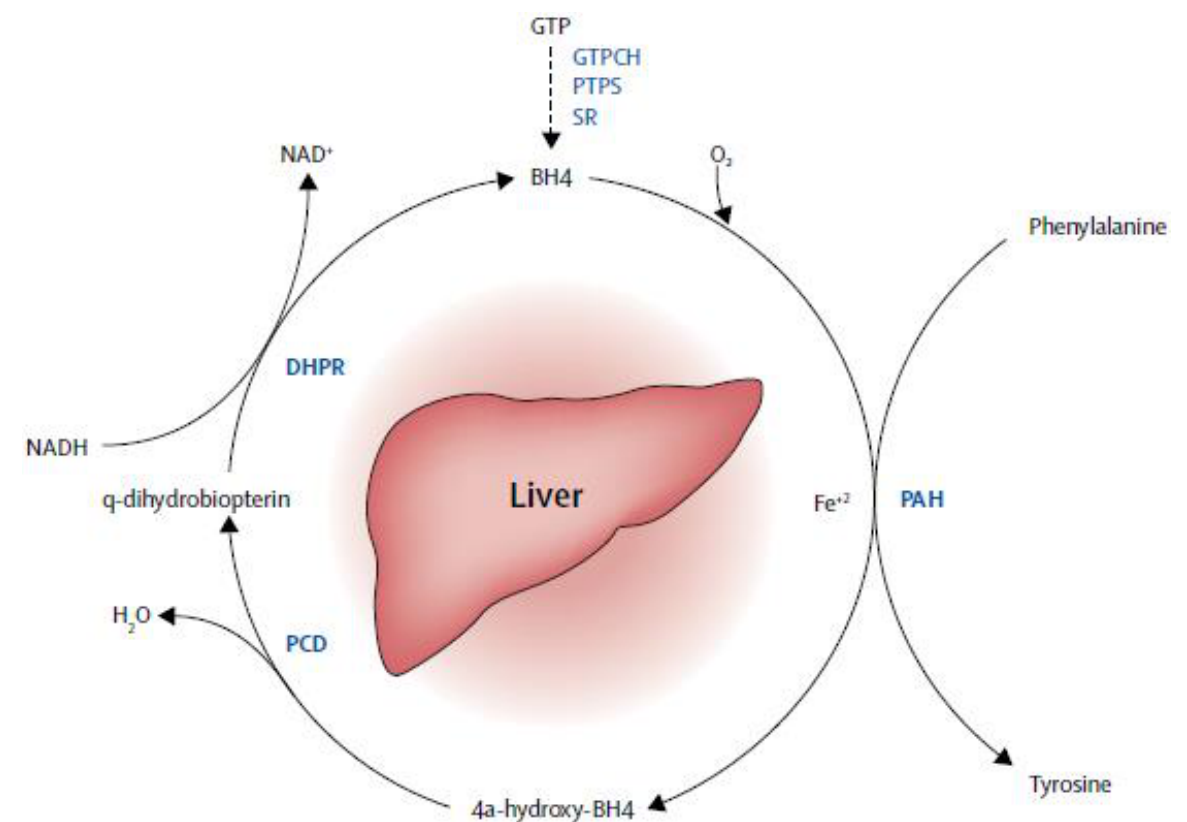
Figure 1. Phenylalanine hydroxylation system.